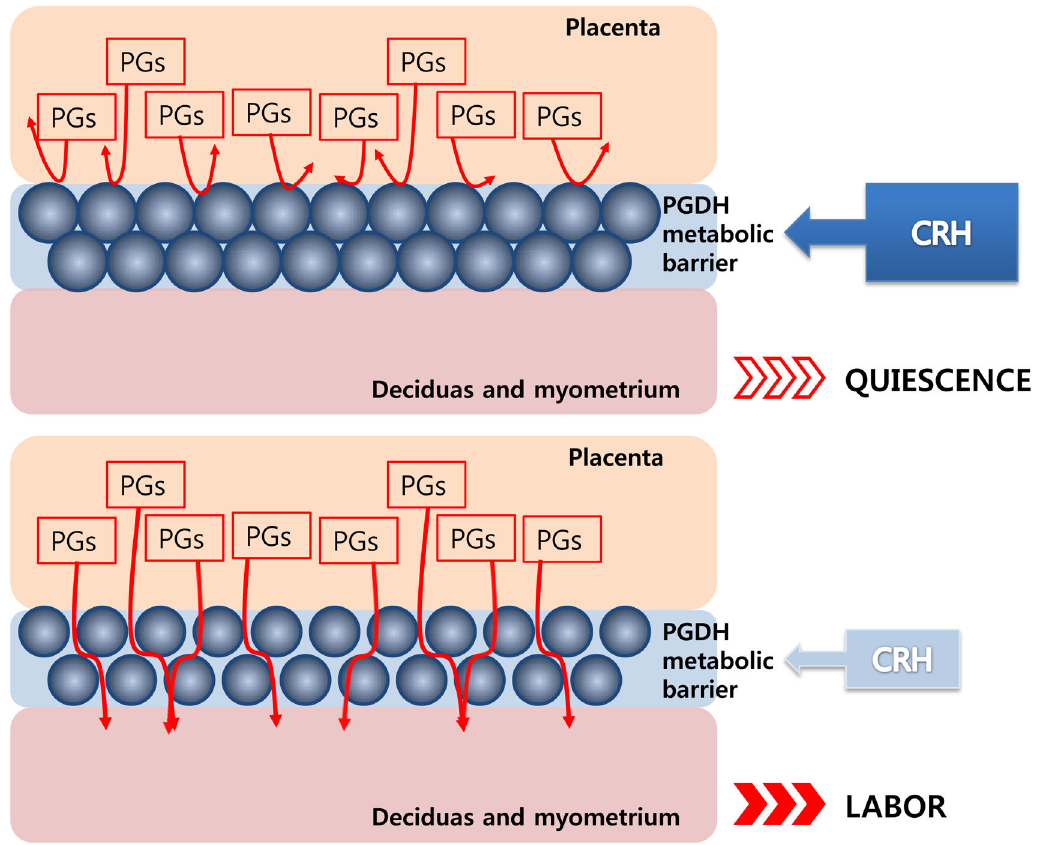
Figure 5. A schematic illustration representing the action of CRH in the placenta. A schematic illustration of representing the central action of CRH in the placenta. A) High level of CRH stimulates or maintains PDGH activity and acts as a metabolic barrier preventing prostaglandins (PGs) from crossing into the deciduas and myometrium. B) Low levels of CRH do not stimulate or maintain PDGH activity. Therefore, PGs can cross into the deciduas and myometrium, where they cause uterine contraction and labor.